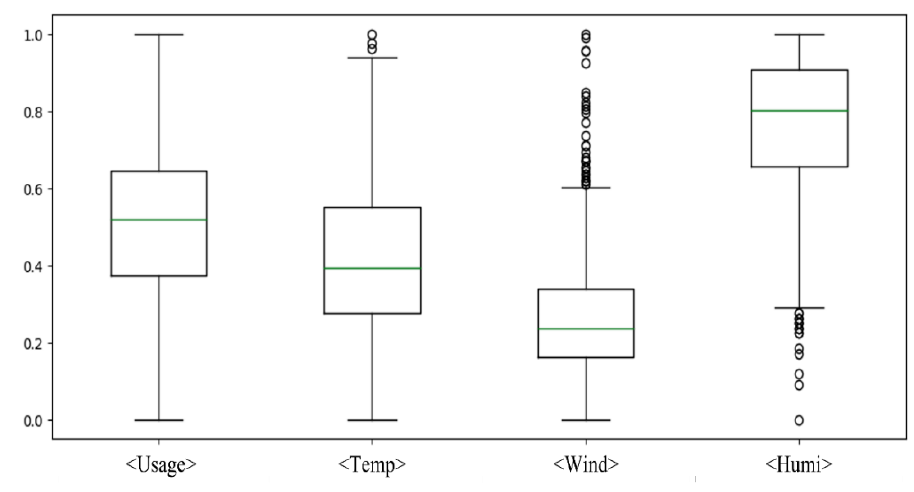
Figure 4. Boxplot of electric power dataset for a specific building.